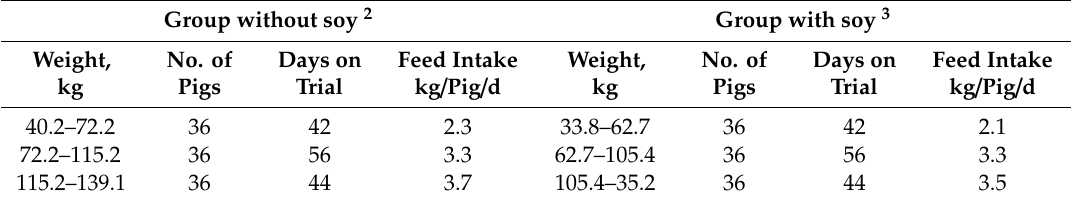
Table A4. Data on Apulo Calabrese breed used for modelling [13] 1